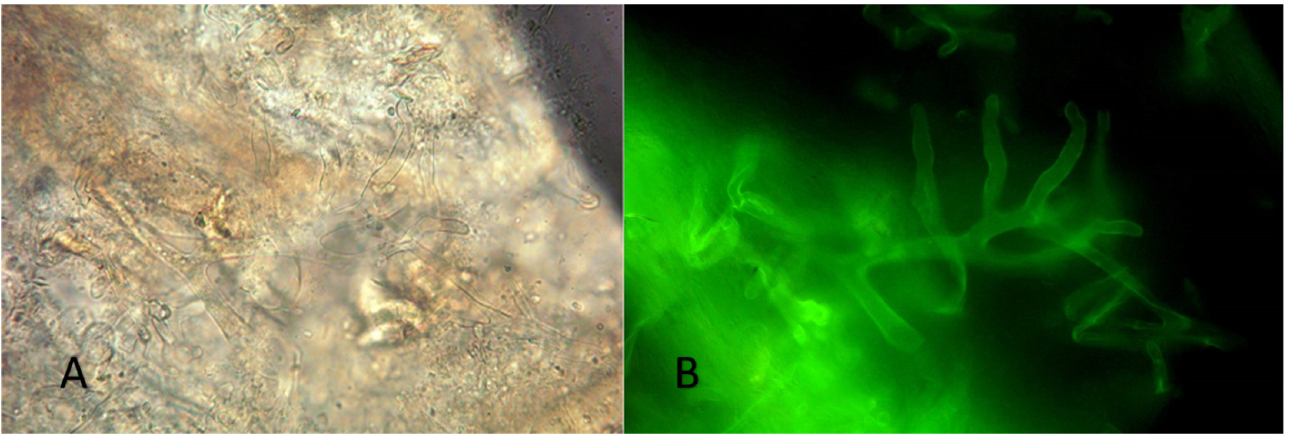
Figure 3. Histopathological examination: intense inflammatory infiltration consisting of neutrophils with many ( A ) hyalines, branched, aseptate hyphae presumptive Mucorales and ( B ) hyalines, branched, septate hyphae, presumptive hyphomycetes other than Mucorales (stain: haematoxylin- eosin, magnification: ×40).